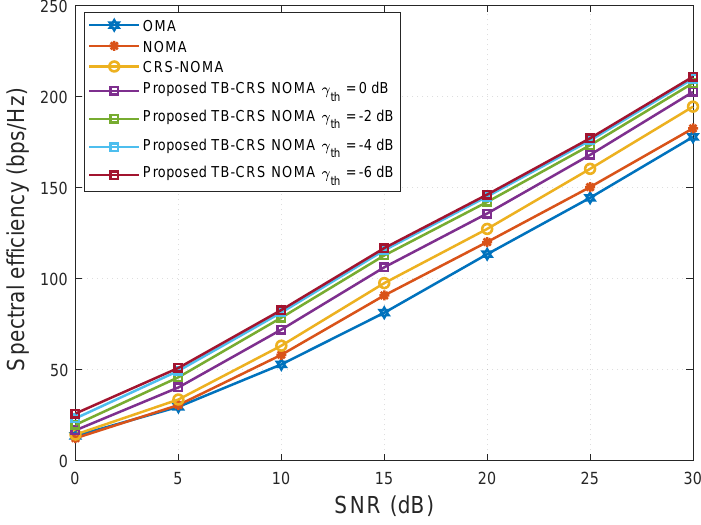
Figure 4. Spectral efficiency versus SNR for K = 32